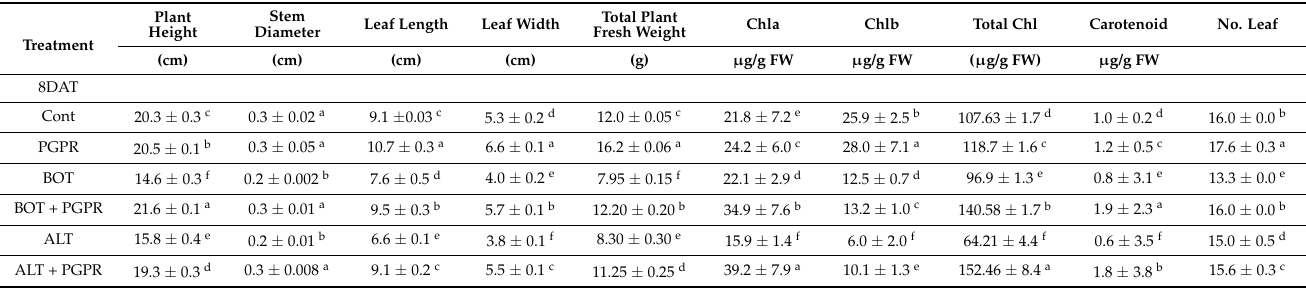
Table 3. Effect of plant growth-promoting rhizobacteria (PGPR) inoculation on pepper plant growth as well as chlorophyll a (Chla), chlorophyll b (Chlb), total chlorophyll (total Chl), and carotenoid contents under normal and stress conditions after eight days.